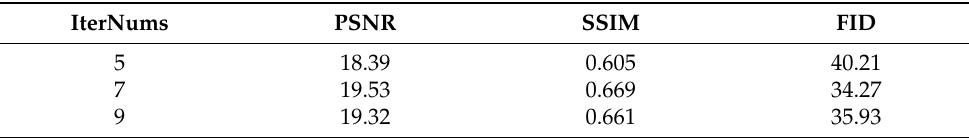
Table 3. The influences of different